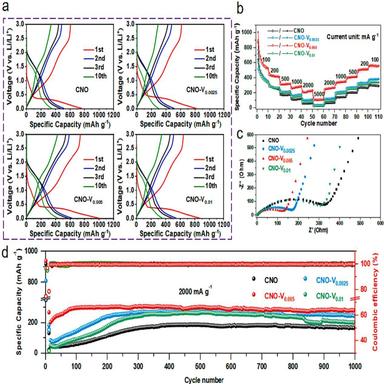
(a) Initial three and tenth charge/discharge curves for CNO nanoparticles with different doping amounts; (b) Rate capability testing of Li half cells at different current densities; (c) EIS spectra of CNO and CNO-Vx; (d) The cycling performance of CNO and CNO-Vx for 1000 cycles at 2000 mA g− 1 .